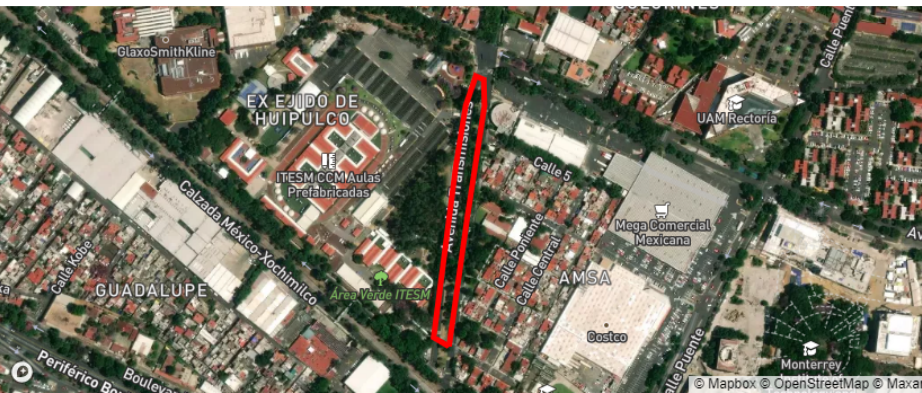
Figure 5. Satellite view of the reference street.